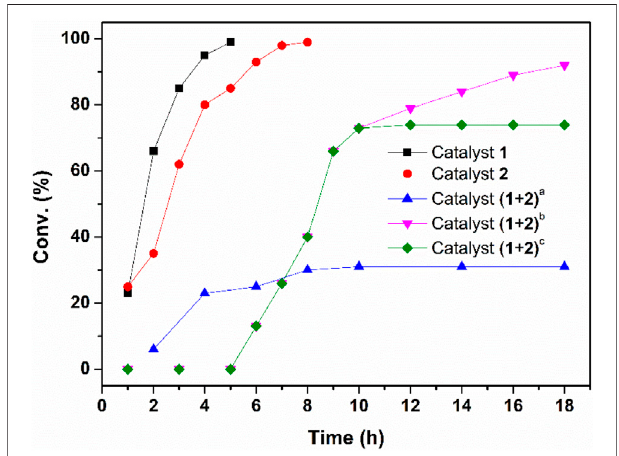
FIGURE 5 | Kinetic results of the one-pot hydration-ATH sequential reaction of phenylacetylene.